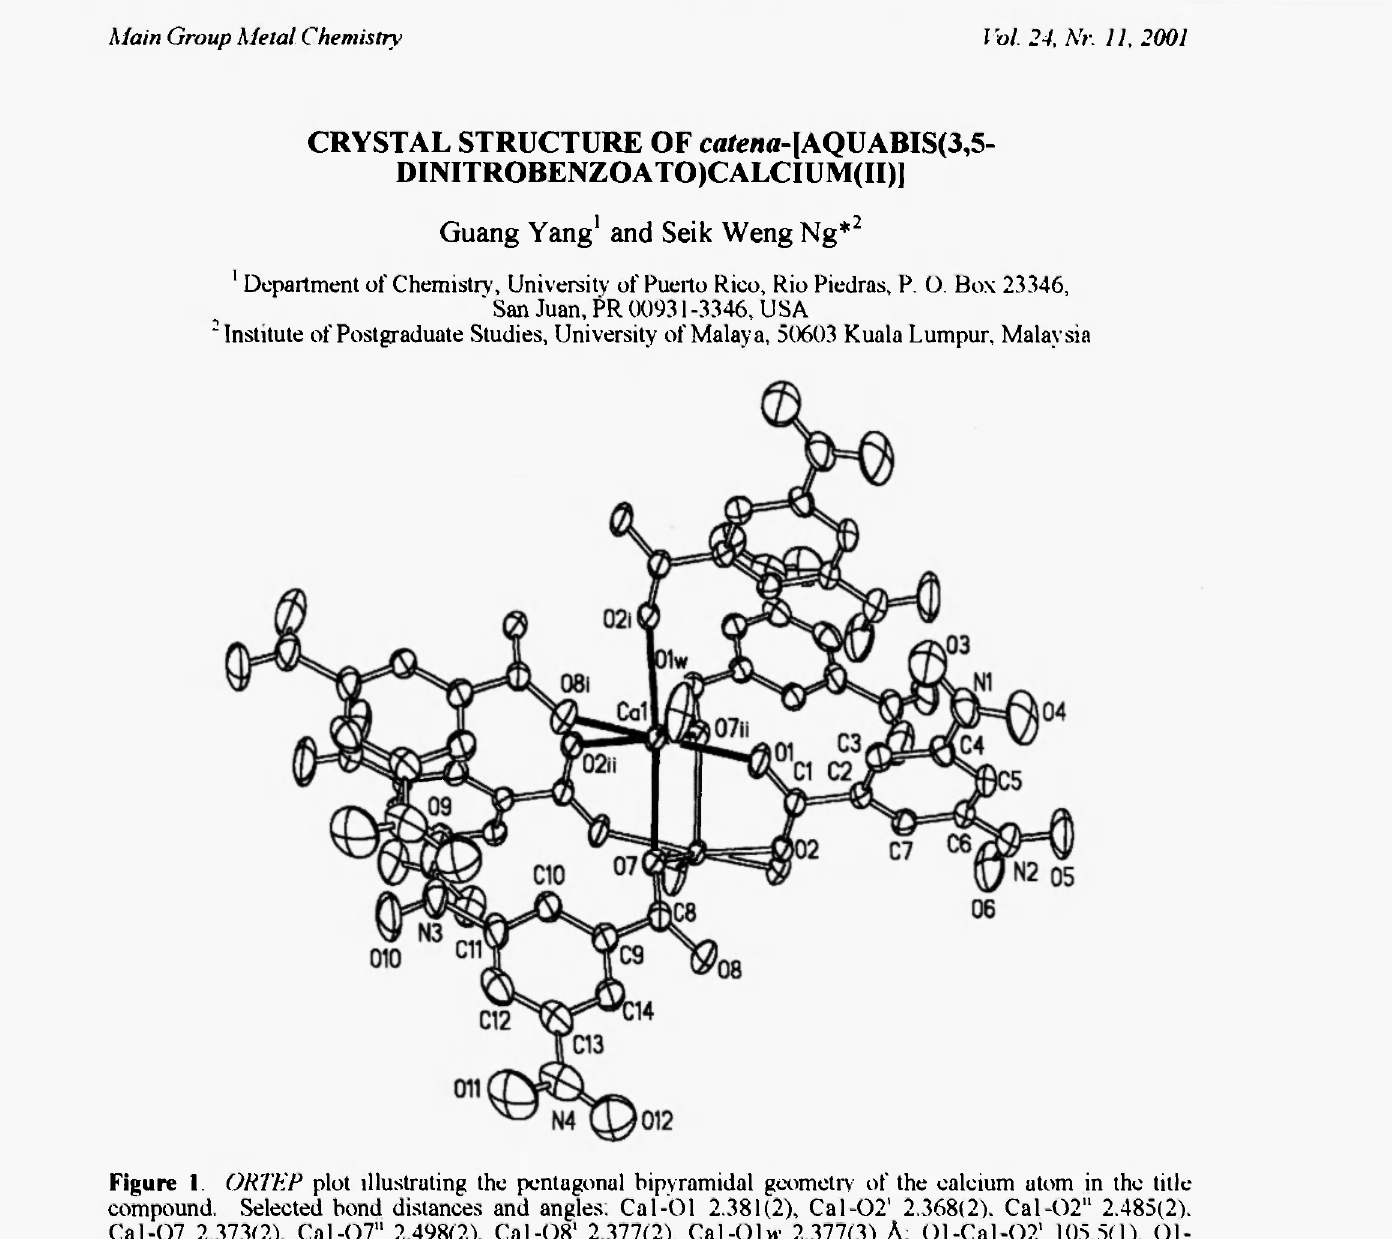
Figure 1. ORTKP plot illustrating the pentagonal bipyramidal geometry of the ealeium atom in the title compound. Selected bond distances and angles. Cal-Öl 2.381(2), Cal-02 1 2.368(2). Cal-02" 2.485(2). Ca 1 -07 2.373(2), Cal-07" 2.498(2), Cal-08' 2.377(2), Cal-Olu· 2.377(3) A; Ol-Cal-02' 105.5(1), Ü1- Ca 1 -02" 145.9(1), 01-Cal-07 81.4(1), 01-Cal-07" 74.1(1), Ol-Cal-OS 1 141.5(1), Ol-Cal-Olw 72.5(1). 02'-Ca 1-02" 84.0(1), 02'-Cal-07 162.9(1). 02'-Cal-07" 81.3(1), 02'-Cal-08' 82.2(1). 02'-Cal-0b»· 89.2(1), 02"-Cal-07 81.9(1), 02"-Cal-07" 75.3(1), 02"-Cal-08' 71.4(1), 02"-Cal-01w 141.2(1), 07- Cal-07" 85.8(1), 07-Cal-08' 102.2(1), 07-Cal-01w 107.8(1), 07"-Cal-08' 144.0(1), 07"-Cal-0ht· 141 3( 1), 08'-Ca 1 -01 w 69.9( 1) ° Symmetry/translational code: / = .ν, 1 + >·, z. ii = 0.5 - ν, 1.5 ->·, 1 -